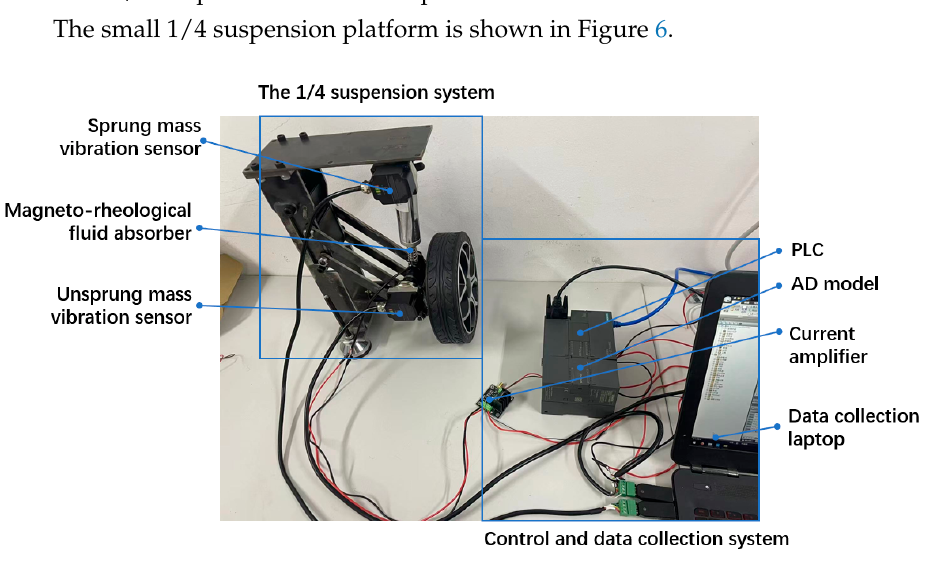
Figure 6. Physical Suspension